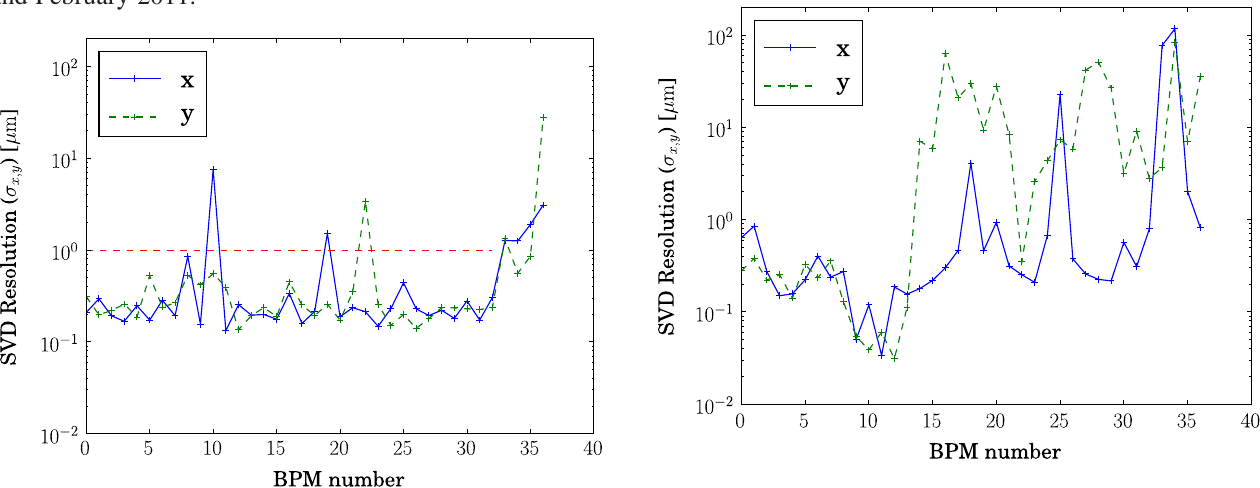
FIG. 20. Resolution of all of the BPMs along the beam line using data from April 2010. The orbit was tuned to unsaturate the 4 C -band CBPMs without